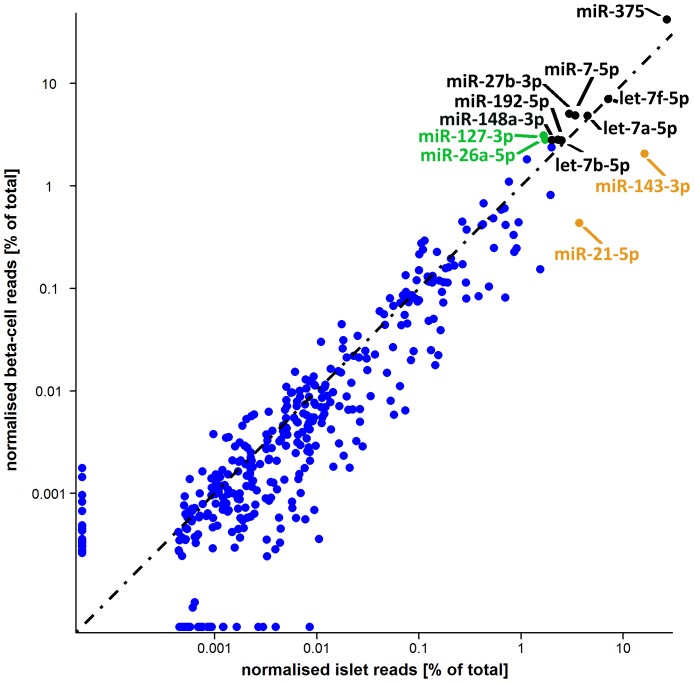
Islet and beta-cell miRNA profiles.The top 10 most abundant miRNAs in islets and beta-cells are annotated, with colors denoting those shared between the two top 10s (black), in islet top 10 only (orange), and in beta-cell top 10 only (green). There was good correlation between the two profiles (r2 = 0.78). A black dashed line represents equality.